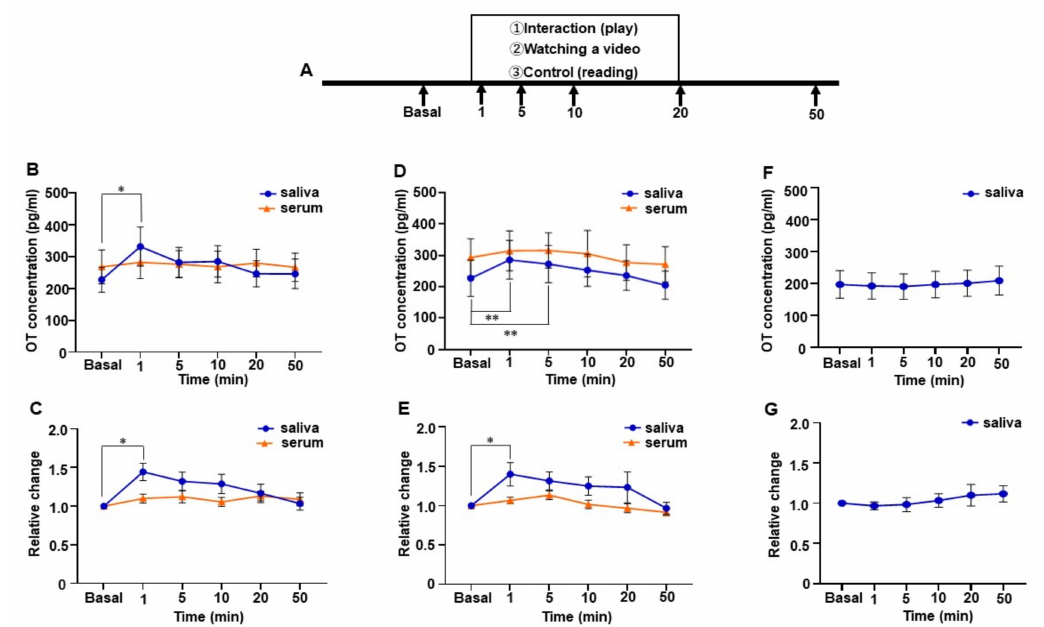
Figure 6. Changes in salivary and serum oxytocin (OT) concentrations of a group of mothers. ( A ) Schematic procedure of the direct mother-infant social interaction, video-watching, and read- ing tests. ( B ) Salivary and serum OT level during the direct mother-infant social interaction test. ( C ) Relative change in salivary and serum OT during the direct mother-infant interaction test. ( D ) Salivary and serum OT level while watching the video of the infants. ( E ) Relative